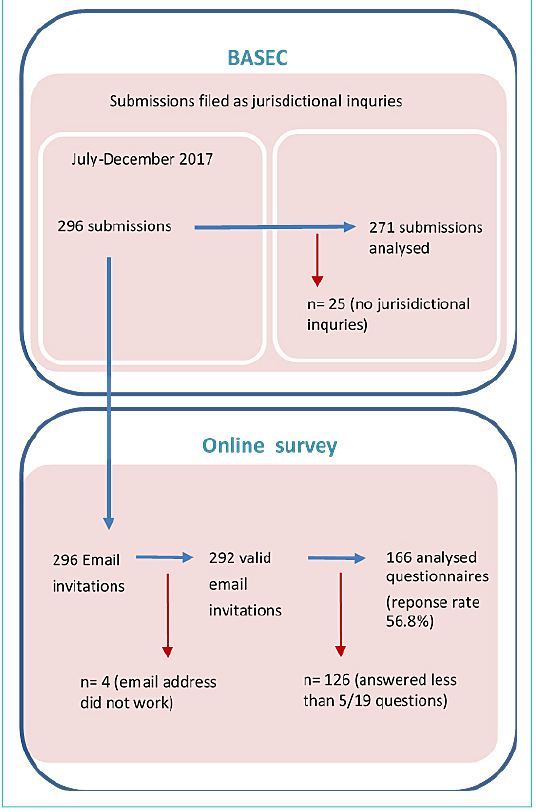
Figure 1: Definitions of the analysis sets for (a) the qualitative re- view of jurisdictional inquiries and (b) the quantitative survey of submitting